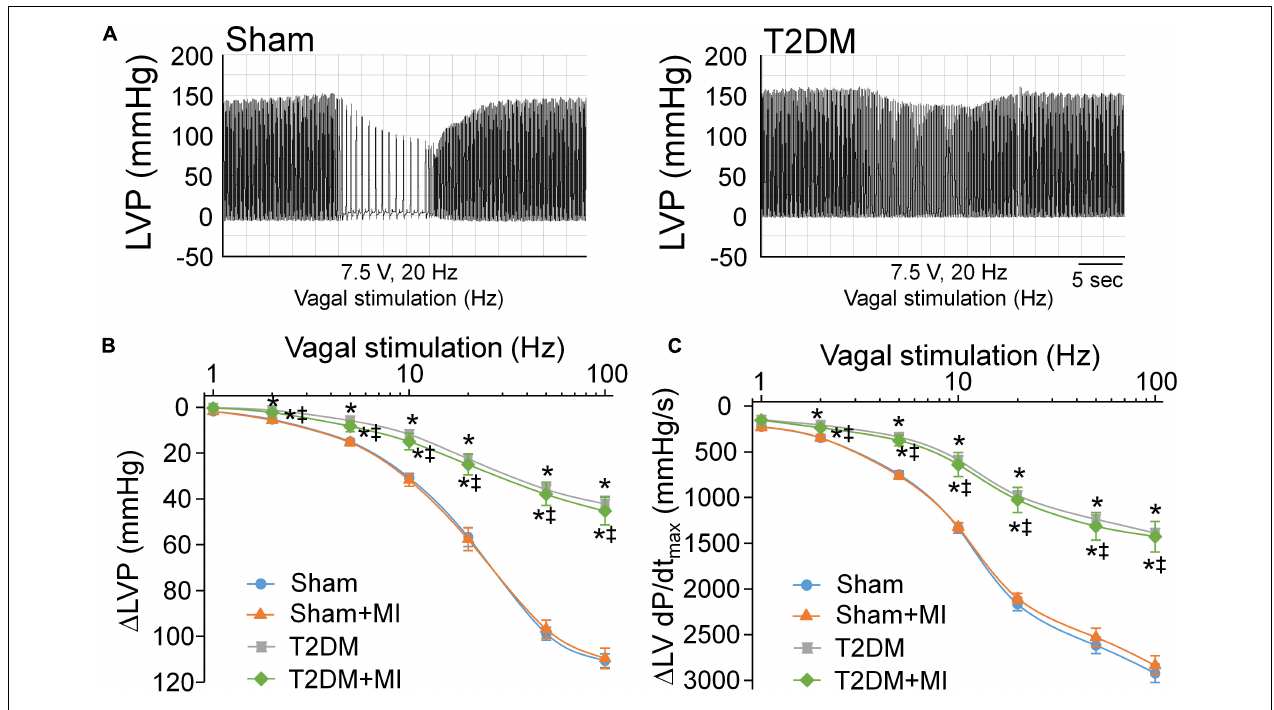
FIGURE 6 | Vagal control of ventricular function determined by changes of left ventricular systolic pressure (LVSP) and the maximum rate of increase of left ventricular pressure (LV dP/dt max ) in response to different frequencies of left vagal efferent nerve stimulation in all experimental groups of anesthetized rats. (A) : Representative recordings demonstrating change of LVSP in response to 7.5 V, 20 Hz of left vagal efferent nerve stimulation in sham and T2DM rats. (B,C) : Quantitative data for changes of LVSP (B) and LV dP/dt max (C) in response to different frequencies (1–100 Hz) of left vagal efferent nerve stimulation in all groups of rats. T2DM blunted the vagal control of ventricular function, as demonstrated by reduced changes of LVSP and LV dP/dtmax in response to vagal efferent nerve stimulation. MI had no effect on vagal control of ventricular function in both sham and T2DM rats. Data are means ± SEM; n = 3–6 rats per group. Statistical significance was determined by one-way ANOVA with post-hoc Bonferroni test. * P < 0.05 vs. sham; ‡ p < 0.05 vs.